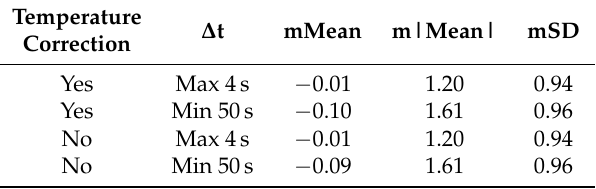
Table 3. Effect of temperature correction on relative camera accuracy estimates. mMean = average